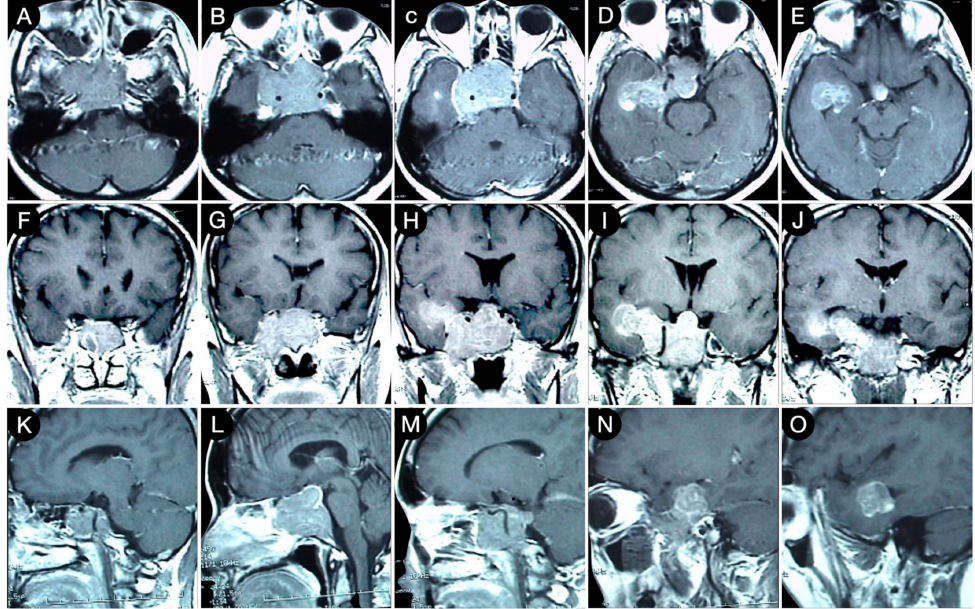
Figure 5. Preoperative axial ( A – E ), coronal ( F – J ), and sagittal ( K – O ) T1-weighted contrast-enhanced MRI. Scale bar: 5